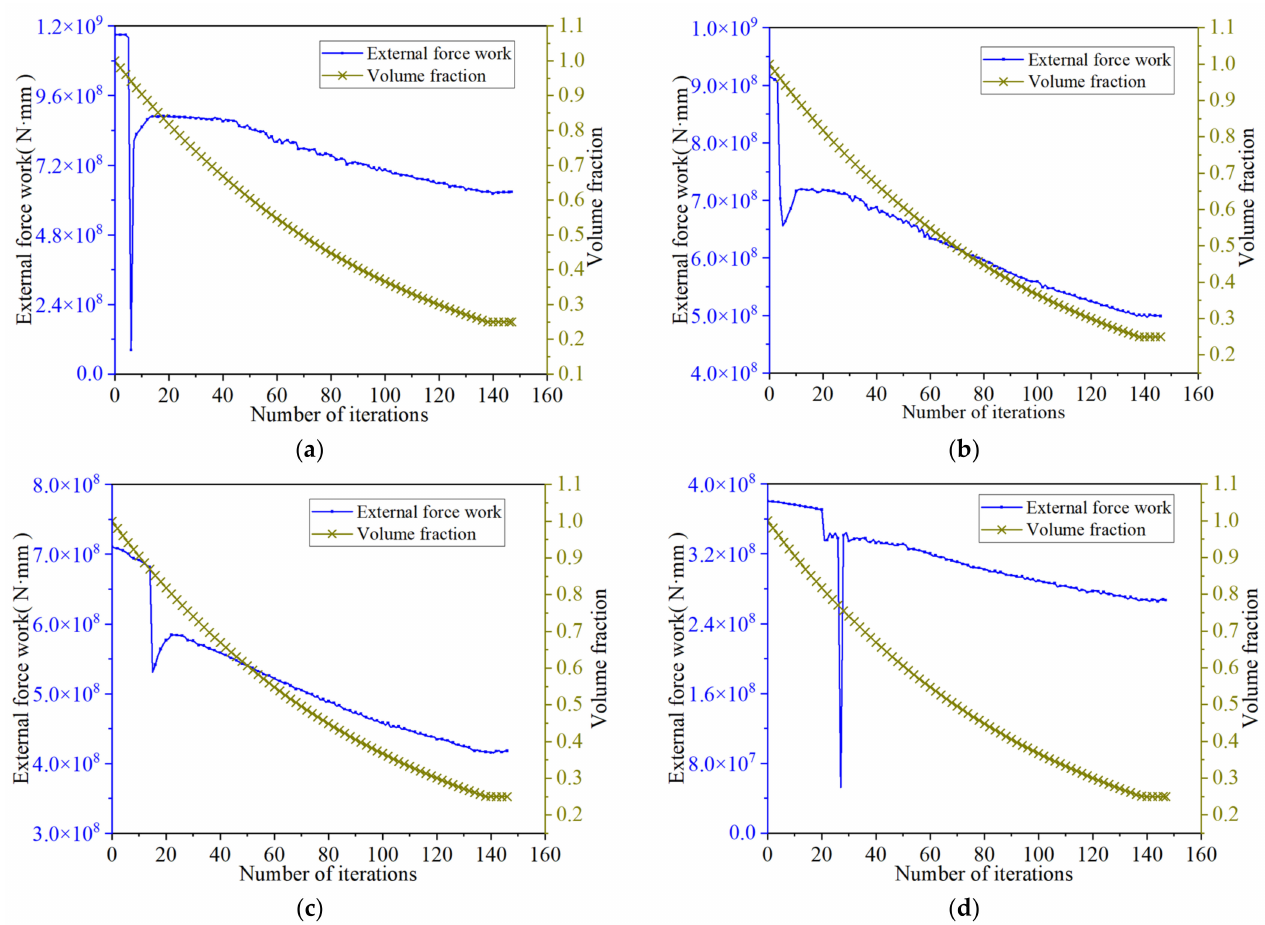
Figure 11. Iterative results of external force work and volume fraction of nonlinear optimization SPSW. ( a ) Aspect ratio of 0.5 ( b ) Aspect ratio of 0.75 ( c ) Aspect ratio of 1.0; ( d ) Aspect ratio of